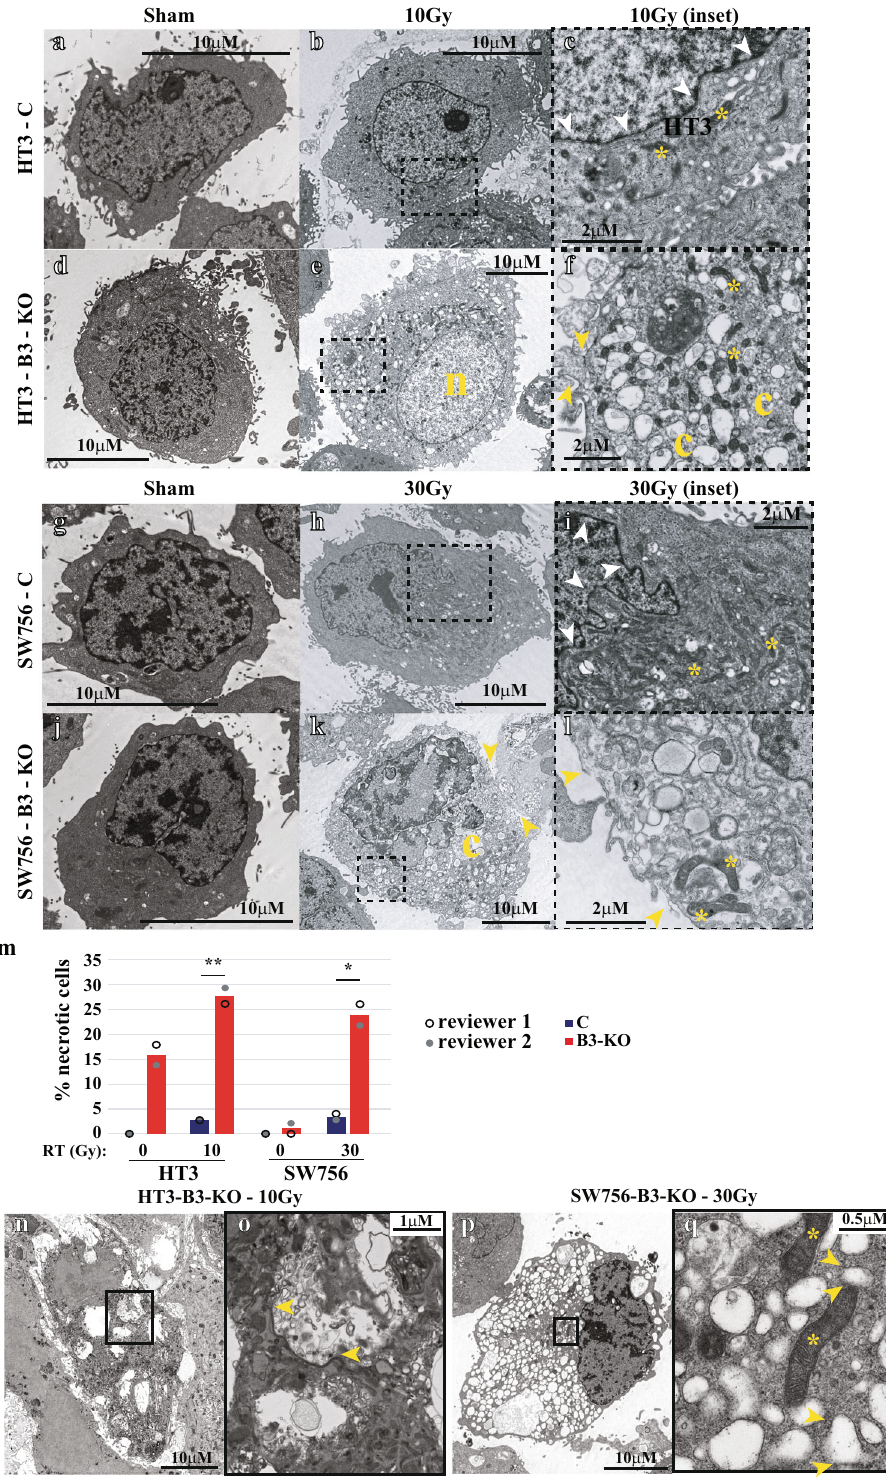
Fig. 4 Cell death in B3-KO cells following RT is primarily necrotic. a – m Transmission electron micrographs of HT3 ( a – f ) and SW756 ( g – l ) B3-WT and B3-KO cells 96 h after treatment with Sham or indicated doses of RT. Black scale bars shown for each image. Inset ( c , f , i , l ) shows magni fi ed images of irradiated cells and are bound by a dashed black box. Yellow arrows indicate breaks in the plasma membrane, yellow c is cytoplasmic clearing, yellow asterisks indicate mitochondria, and yellow n indicates devolving nucleus. m Quantitation of percent of total cells showing necrotic morphology on 20 random TEM images by two blinded reviewers. Histogram height indicates mean of reviewers, * = student ’ s t -test p -value < 0.05, ** = student ’ s t -test p - value < 0.01. n – q Representative transmission electron micrographs of HT3-B3-KO ( n , o ) and SW756-B3-KO ( p , q ) cells 96 h after treatment with RT, with insets ( o , q ) showing high magni fi cation regions delineated by a black box. Cytoplasmic lysosome-like structures with ruptured membranes are indicated by yellow arrows. Mitochondria marked with yellow